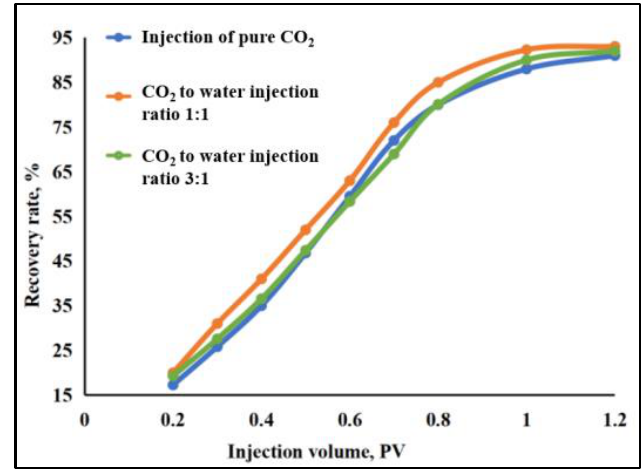
Figure 23. Recovery rate at different injection ratios.